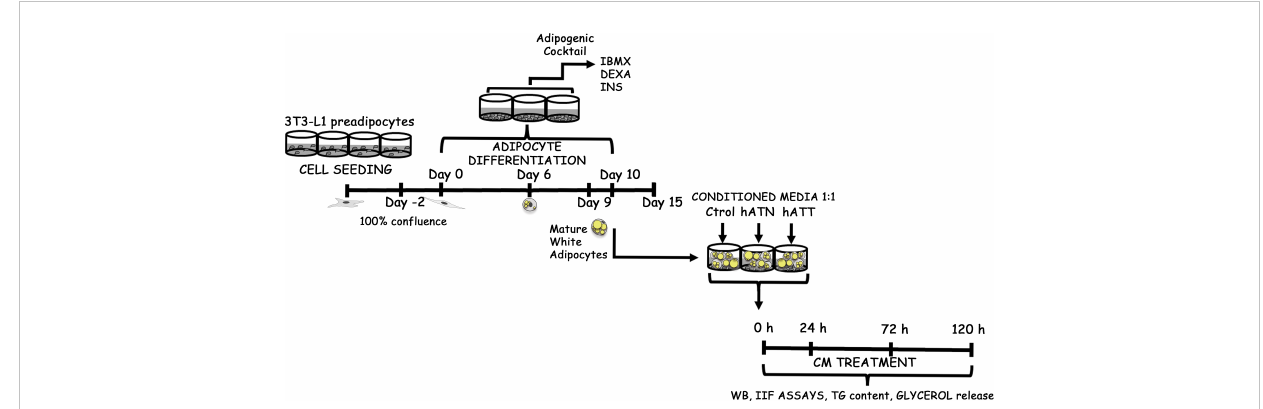
FIGURE 1 Schematic experimental approach. 3T3-L1 preadipocytes were seeded in multiwell plates and allowed to grow until they reached con fl uence on day 0. Two days later, an adipogenic cocktail containing 0.5 mM IBMX, 0.1 m M DEXA, and 0.1 m M rosiglitazone was added to the cells, which were then further cultured for two days. Afterward, the culture medium was replaced with complete D-MEM/F-12 containing 2 m M INS. Adipocytes were maintained in D-MEM/F-12 supplemented with 10% FBS after six days. Following nine days, a vast majority (90-100%) of the cells had differentiated into WAs that exhibited an increase in TG content and the formation of LDs, which were visualized under light microscopy either directly or following Oil Red O staining or Lipid-TOX via IIF. Ctrol-CM, Control conditioned media; hATN-CM, conditioned media from human normal breast adipose tissue explants; and hATT-CM, conditioned media from human breast cancer adipose tissue explants, were used. FBS, Fetal bovine serum; IIF, indirect immuno fl uorescence; ON, overnight; WB, Western blot; TG, triacylglycerol; IBMX, 3-isobutyl-1-methylxanthine; DEXA, dexamethasone; INS, insulin and WA, white adipocyte are the terms used in this